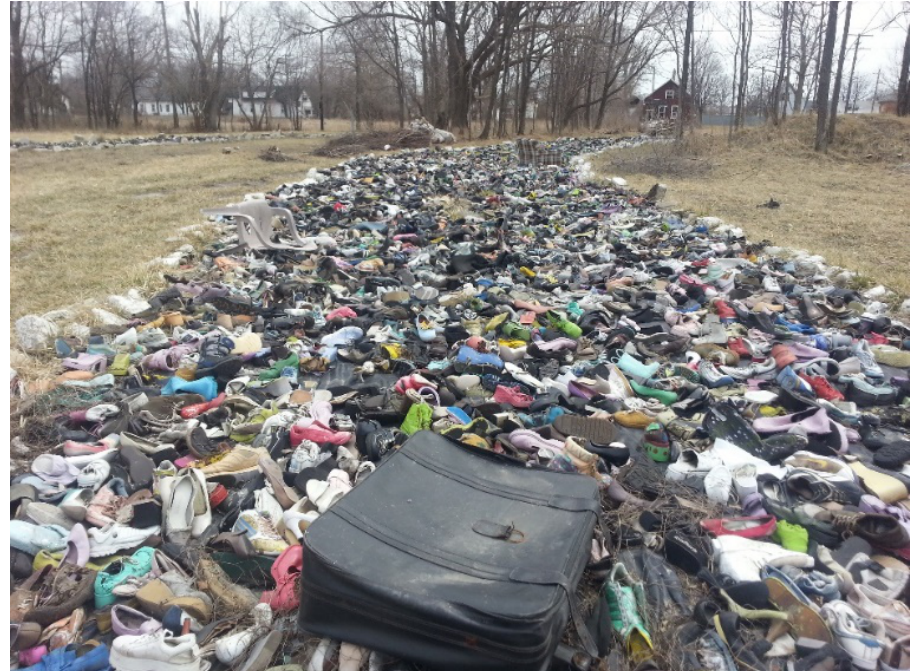
Figure 7. Artist/Activist Tyree Guyton installation on East Side vacant lots, Detroit,